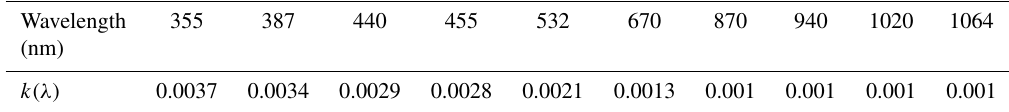
Table 6. Spectral dependence of the complex refractive index of the coarse non-spherical aerosol type.